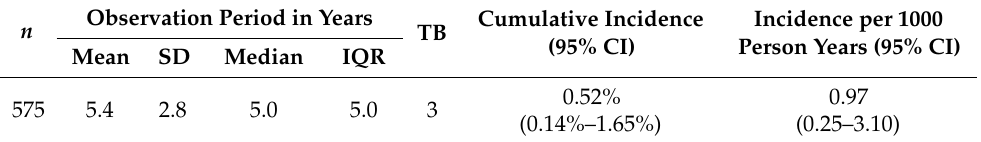
Table 7. Observation period and progression rate among 575 workers with occupational LTBI with code 3101 from the